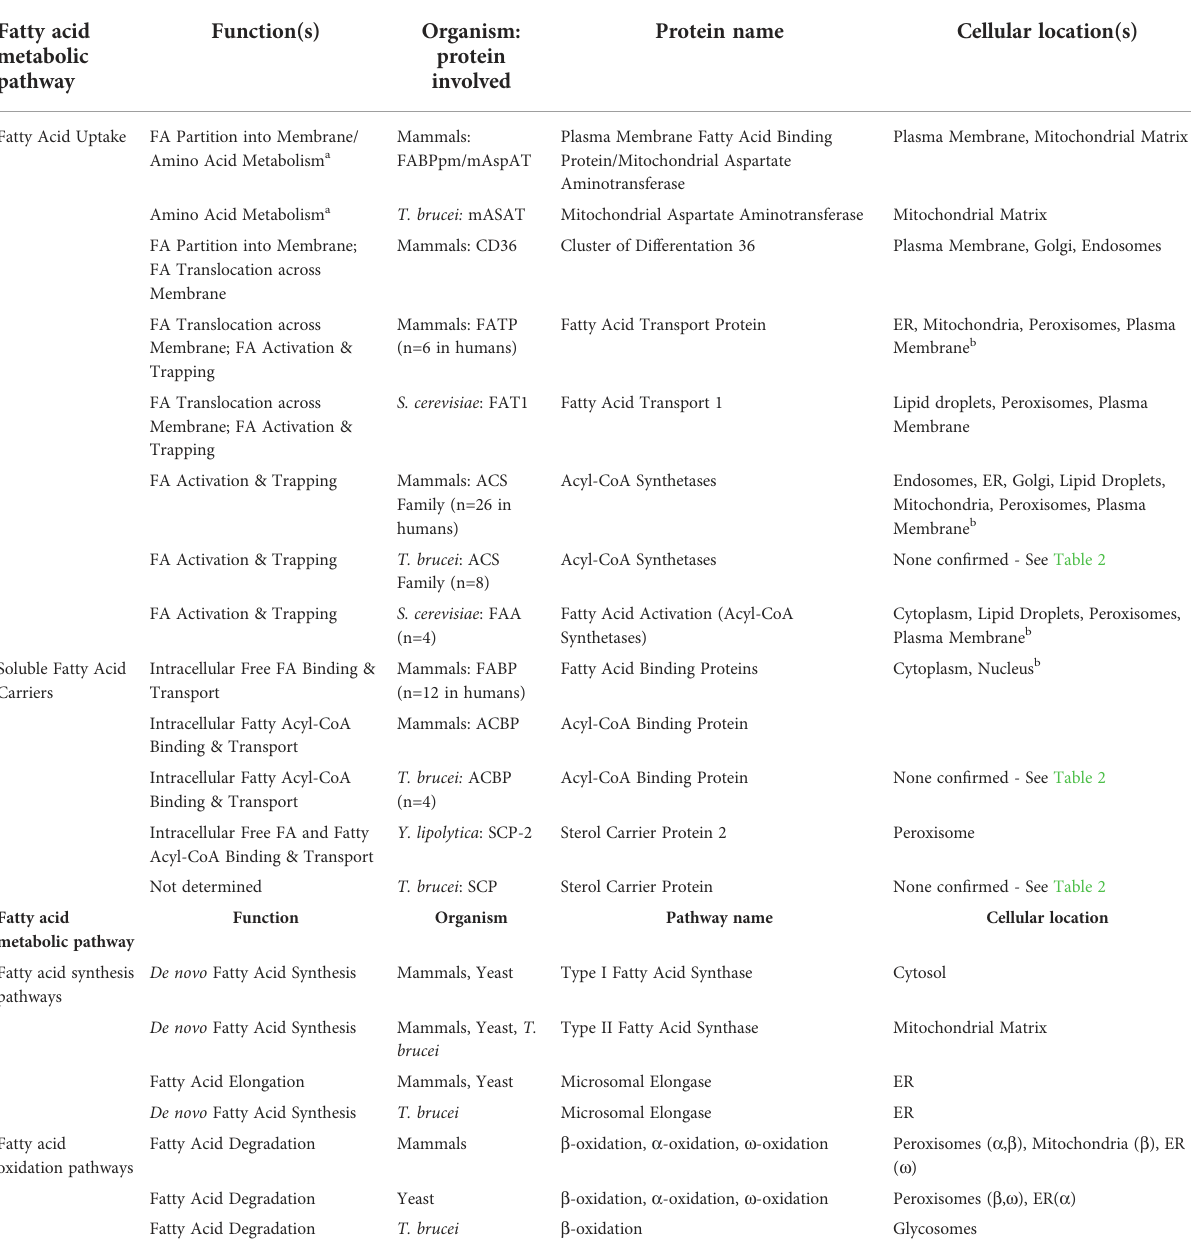
TABLE 1 Fatty Acid Metabolism Proteins and Pathways. Fatty acid metabolic